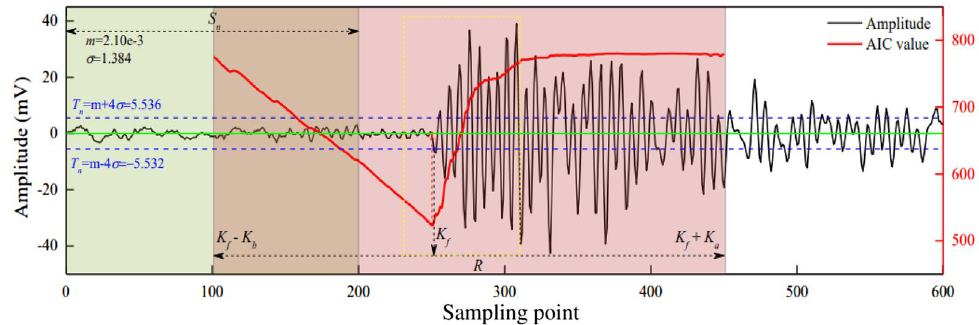
Figure 8. Calculation example of AIC’s function.